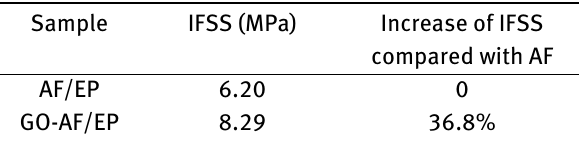
Table 1: IFSS of AF/epoxy composite with AF modified before and after Sample IFSS (MPa) Increase of IFSS compared with AF AF/EP 6.20 0 GO-AF/EP 8.29